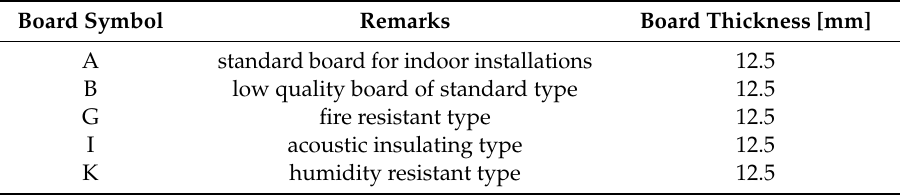
Table 1. Mechanical properties of tested plasterboard compositions.